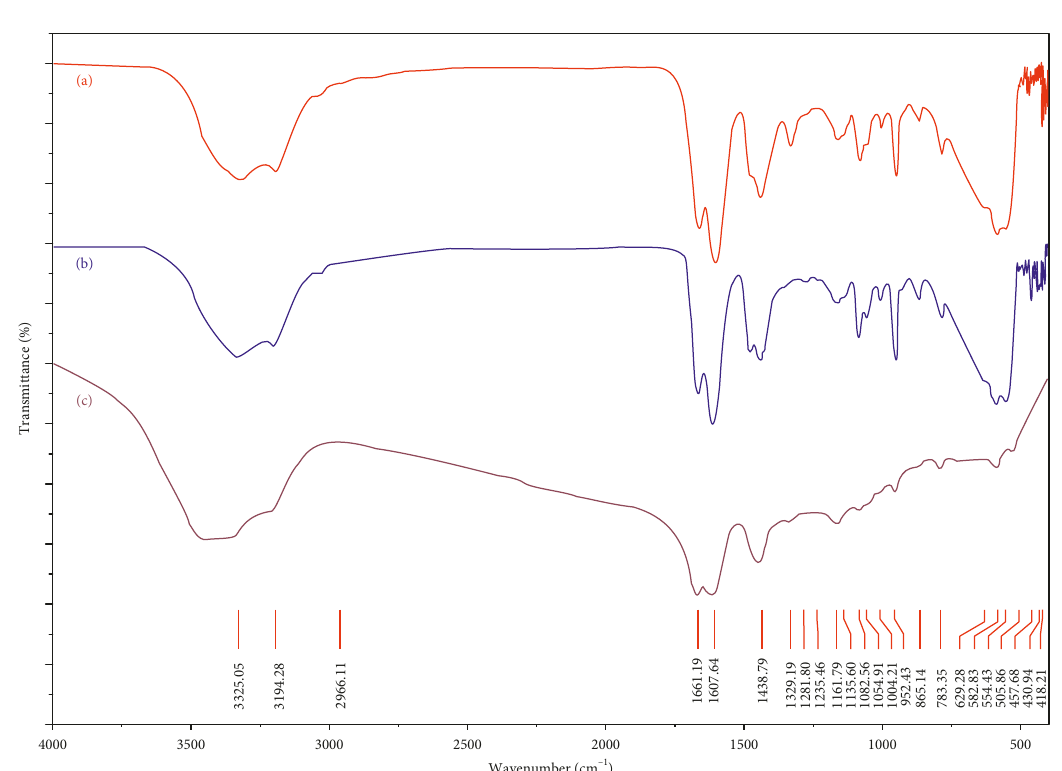
Figure 1: FTIR of DES solutions were synthesized with the choline chloride/urea molar ratios: a-(1 :1), b-(2 :1),